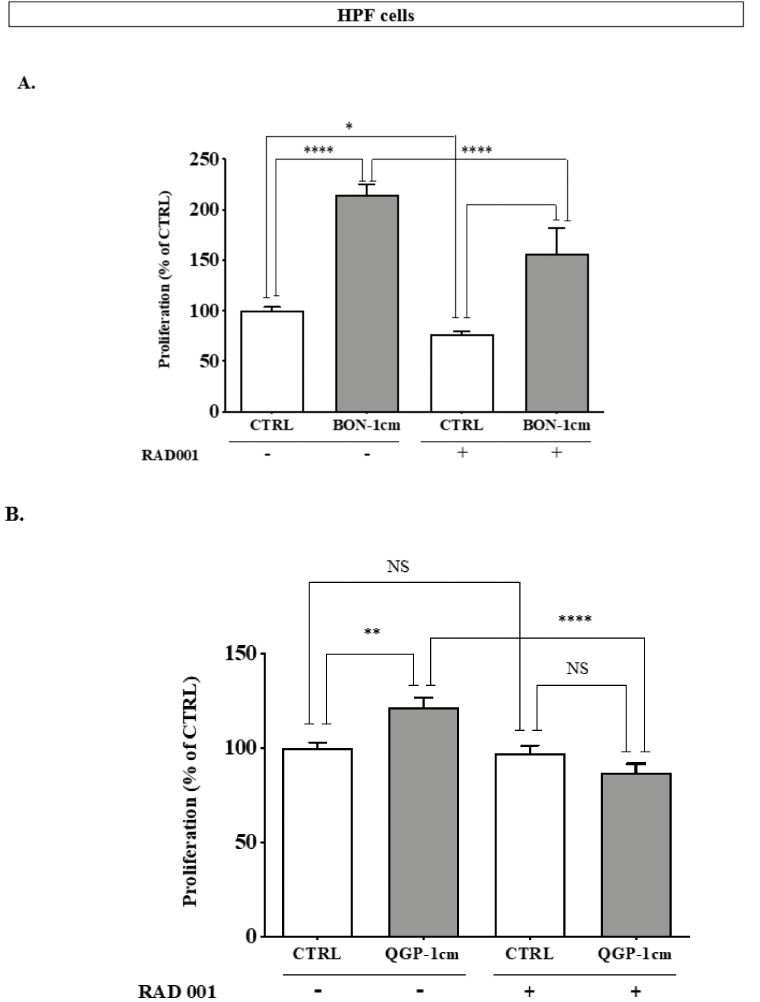
Figure 8. Effect of RAD001 (10 nM) on the proliferation of HPF cells in the presence or absence of BON-1-conditioned medium ( A ) or QGP-1-conditioned medium ( B ). **** p < 0.001; ** p < 0.01; * p <